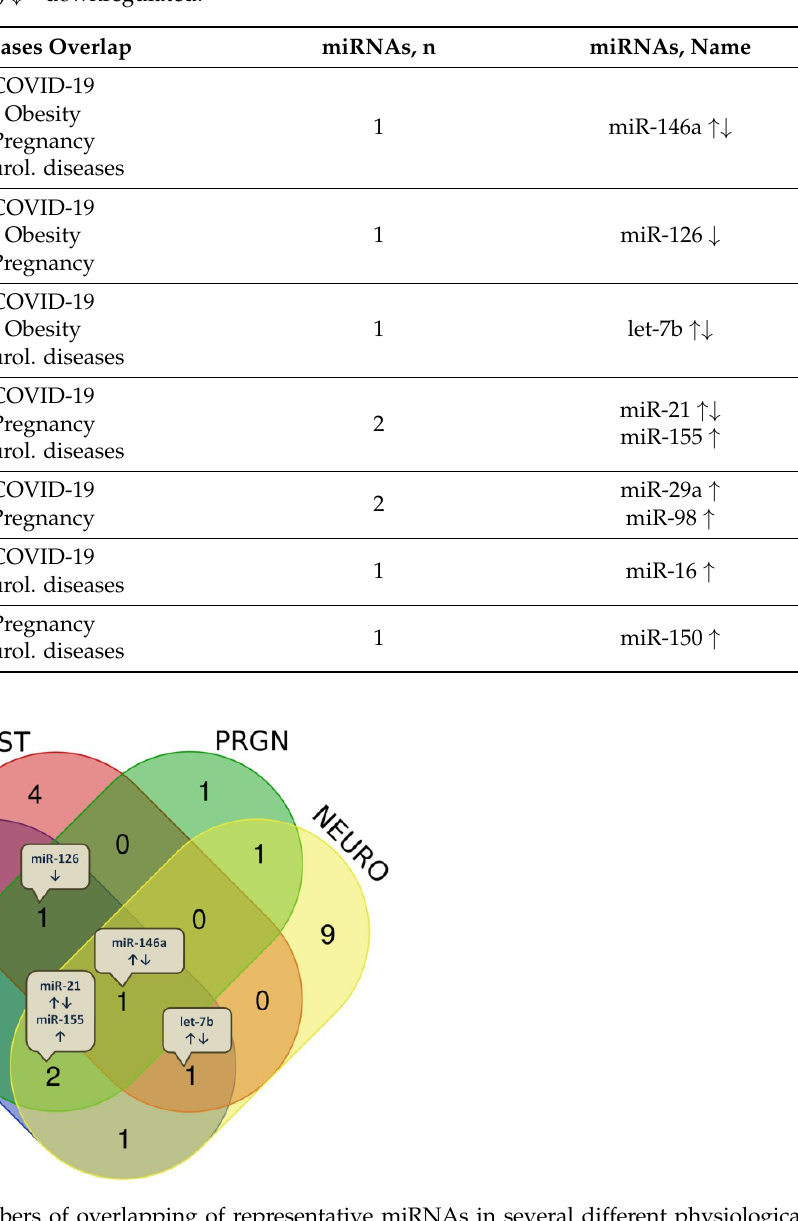
Table 2. A list of same miRNAs involved in COVID-19 and patients with COVID-19 and conditions.